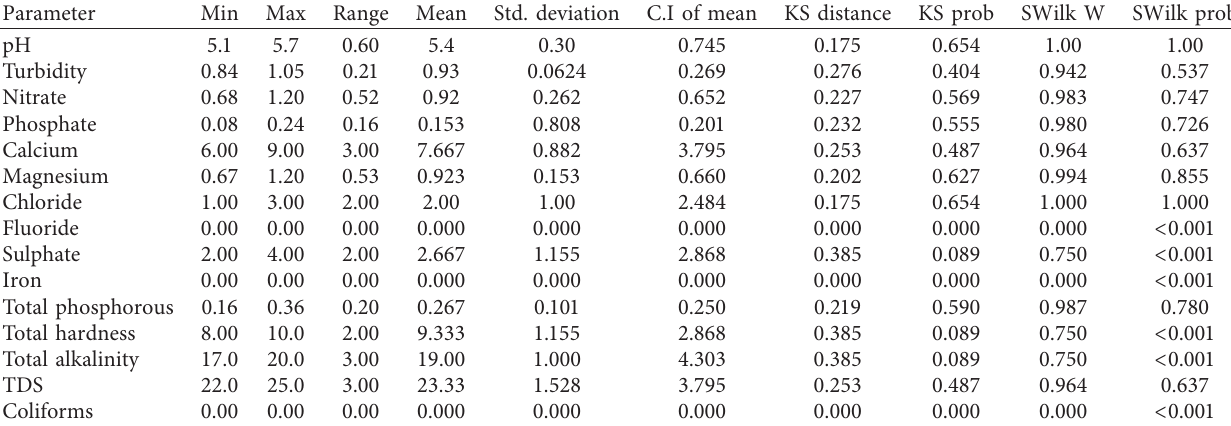
Table 3: Statistical analysis of the observed groundwater quality parameters in the Manga